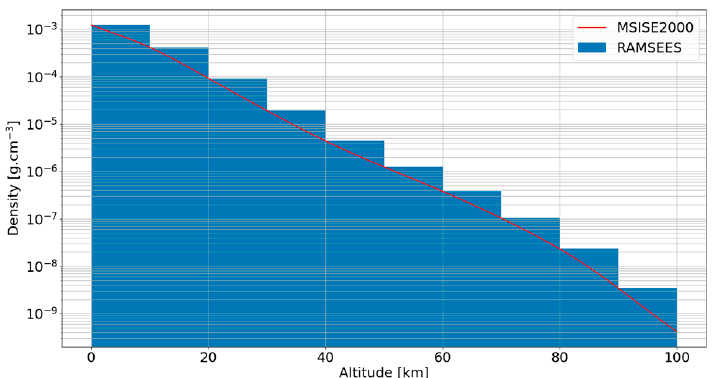
Figure 6. Density of the atmosphere in this work compared to MSISE2000.